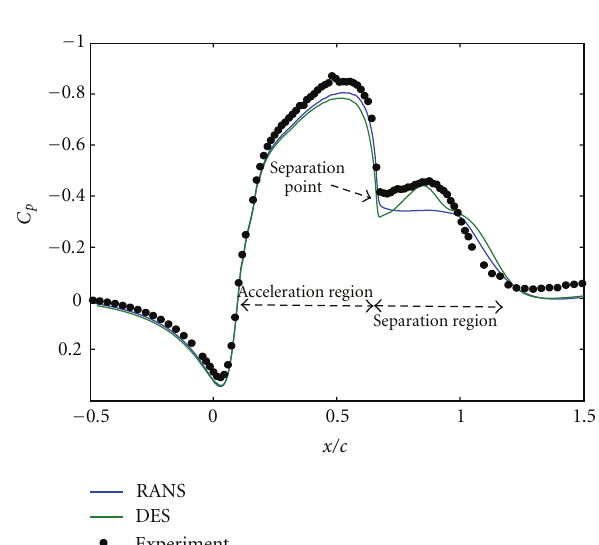
Figure 7: Pressure coe ffi cient comparison.